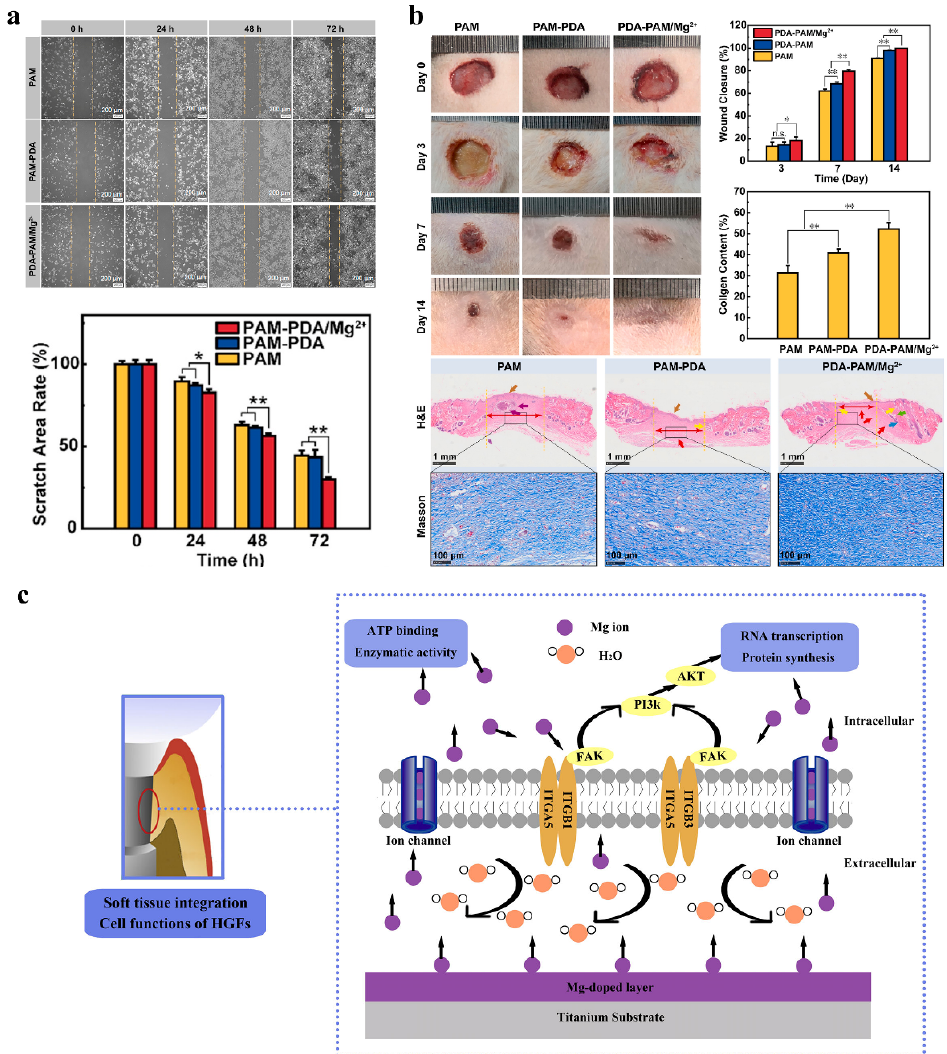
Figure 9. ( a ) The optical images displaying the effect of Mg on L929 cell migration and corresponding calculations on scratch area rate. ( b ) The in vivo wound-healing effects of the PAM, PAM-PDA, and PDA-PAM/Mg 2+ hydrogels, including the micro photographs, calculated wound closure rate, histological section results (H&E and Masson), and derived collagen ratio of the wound tissue post- operation for 14 days. * p < 0.05, ** p < 0.01, ns indicates that the difference between groups is not significant. Reproduced with permission from [135]. Copyright 2021, Elsevier. ( c ) A diagram illustrating the possible action of Mg-modified surfaces on human gingival fibroblasts (HGFs). Reproduced with permission from [137]. Copyright 2019, Wiley Periodicals, Inc.